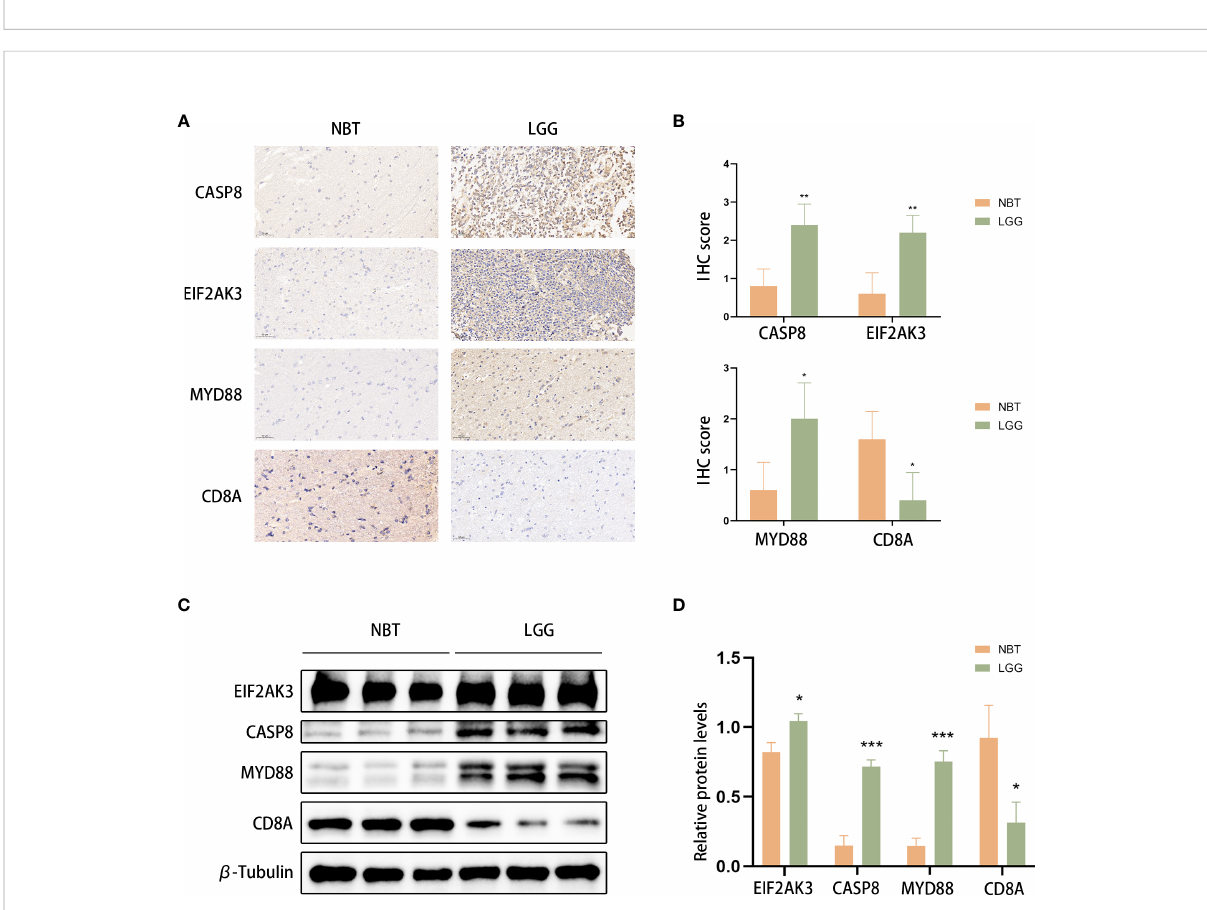
FIGURE 13 CASP8, MYD88, EIF2AK3, and CD8A expression was veri fi ed. (A, B) Representative IHC staining images (A) and IHC scores (B) for CASP8, MYD88, EIF2AK3, and CD8A in clinical tissues. Scale bars: 50 m m. Normal brain tissue: n = 5, LGG: n=5. (C, D) Western blotting was used to detect the protein expression levels of EIF2AK3, Caspase 8, CD8A, and MyD88 in LGG (n=3) and normal brain tissues (n=3). *P < 0.05, **P< 0.01, ***P < 0.001.